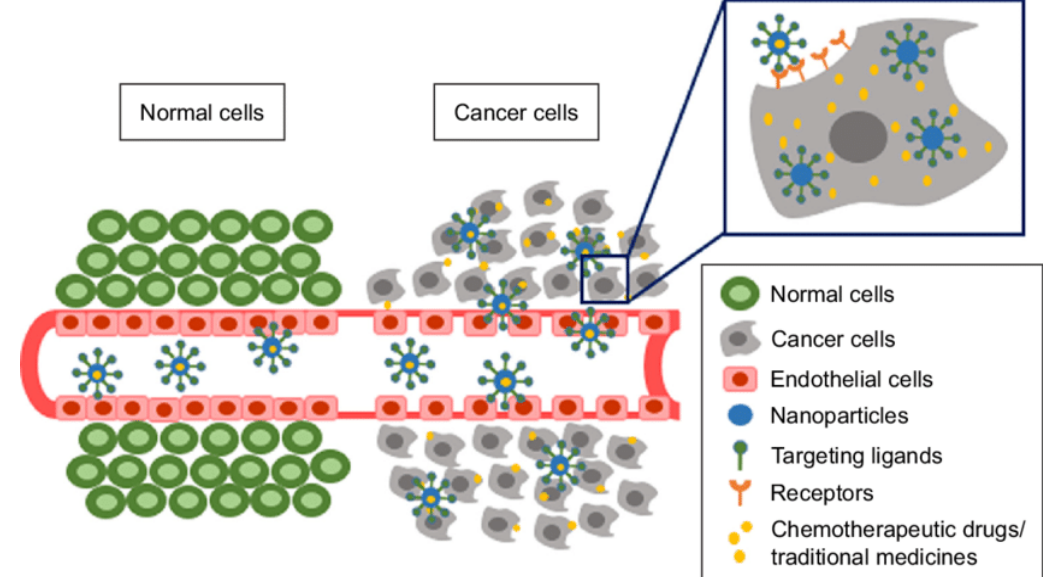
Figure 1. Nanoparticles can preferentially be taken up by cancer cells through passive targeting, active targeting (blue box), or both mechanisms. (Adapted from Ref. [40]).